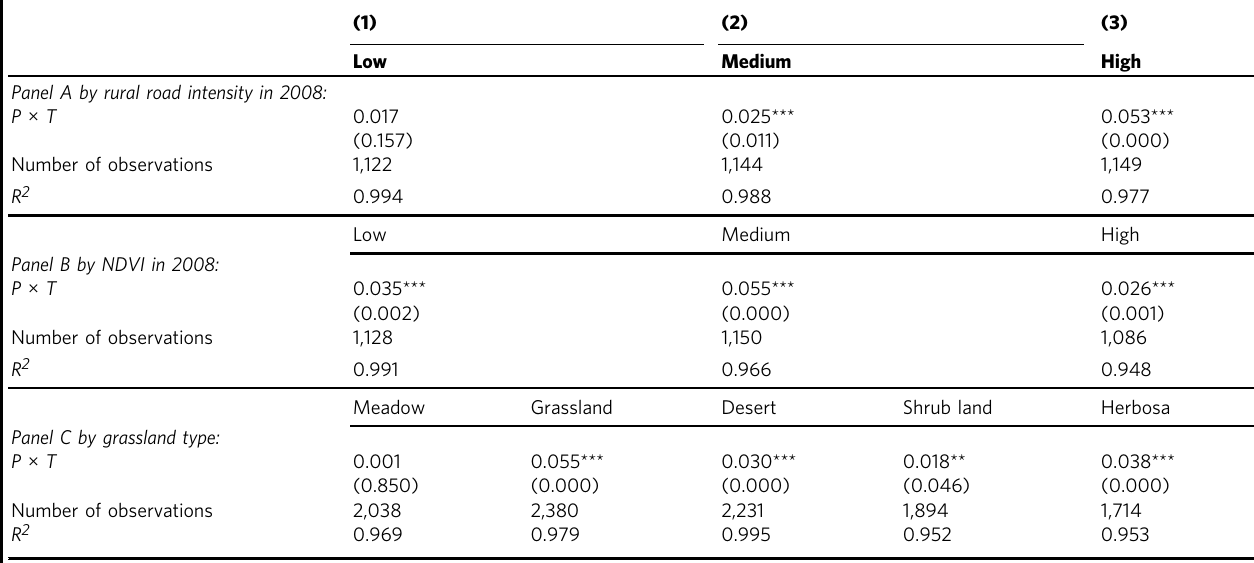
Table 6 Estimated heterogeneous impacts of the Grassland Ecological Compensation Program (GECP) on grassland quality: county level.